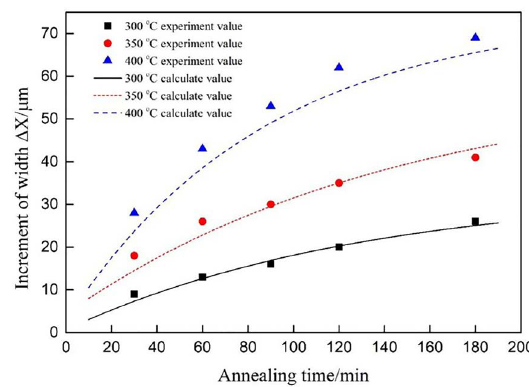
Figure 7. The comparison of width increment of the interfacial transition zone between experiment and